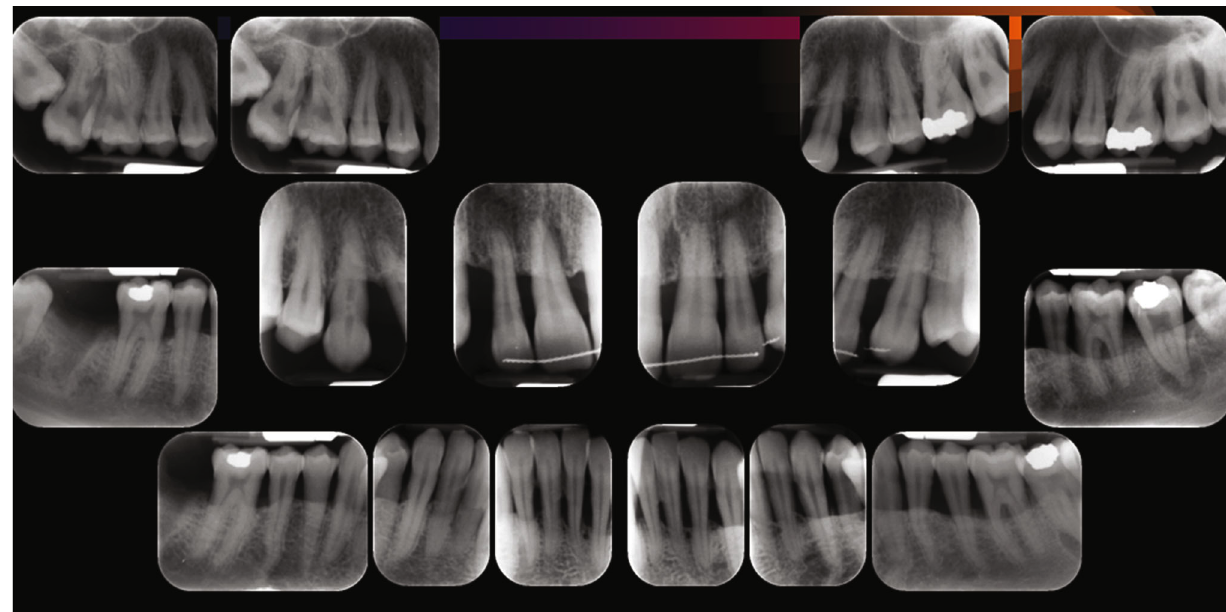
Figure 4: Rx full endoral clinical case: